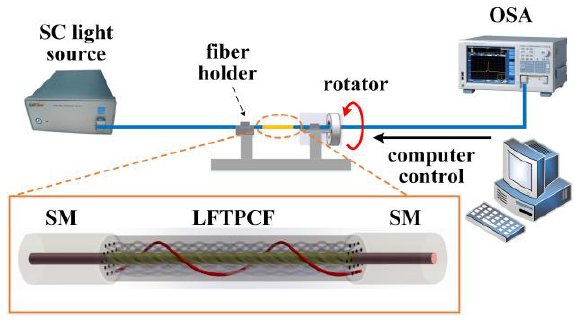
Figure 7. A schematic of the torsion test; inset is the structure diagram of the LFTPCF sensor.